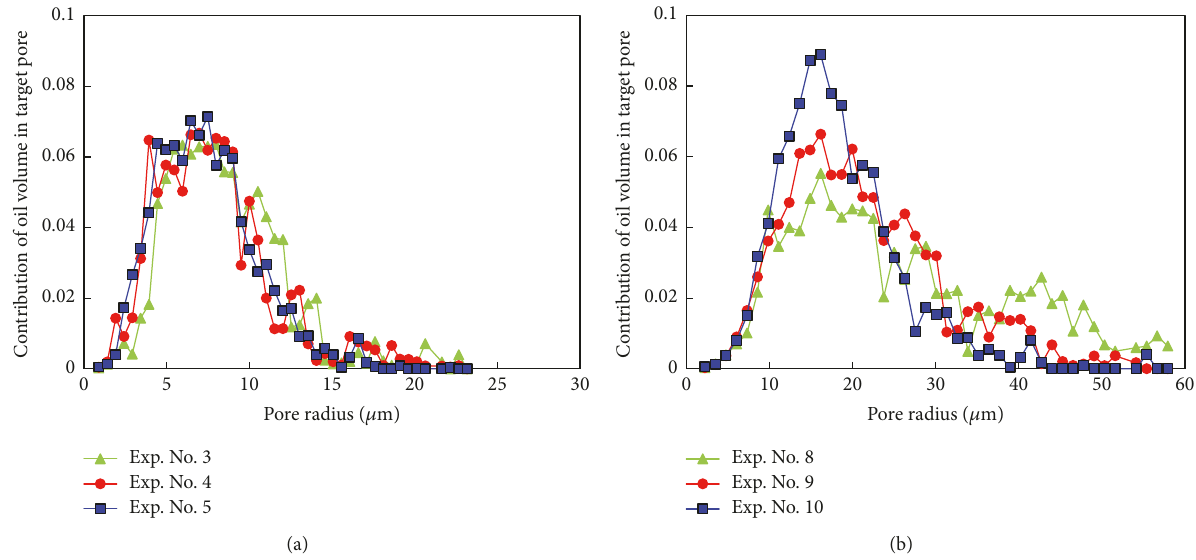
Figure 12: Contribution of oil volume versus target pore radius during the water flooding experiments: (a) water-wet plug; (b) oil-wet plug.